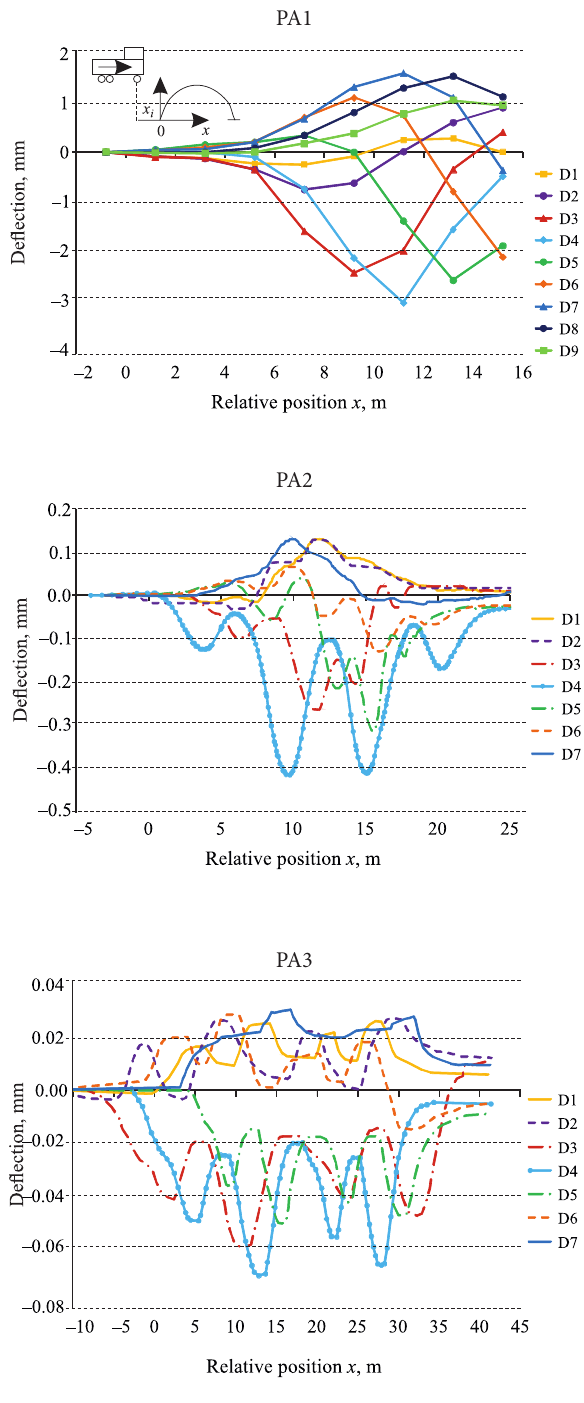
Fig. 4. Results of load tests of the